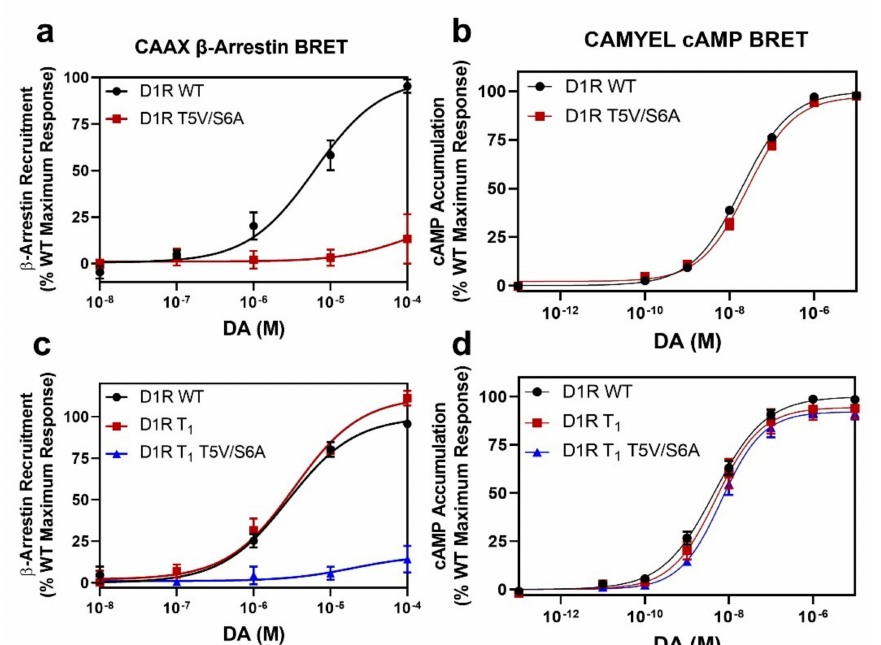
Figure 5. The T5S6 C-terminal phosphorylation sites are major drivers of β -arrestin recruitment to the D1R. CAAX β -arrestin recruitment and CAMYEL cAMP accumulation assays were performed as de- scribed in Section 4. Data are expressed as a percentage of the maximum D1R WT DA response in each experiment and are displayed as the mean ± SEM of at least three experiments, performed in triplicate. Statistical comparisons between the following D1R WT and mutant curve parameters were made us- ing a one-way ANOVA with Dunnett’s post hoc comparison: * p < 0.05, *** p < 0.001, and **** p <